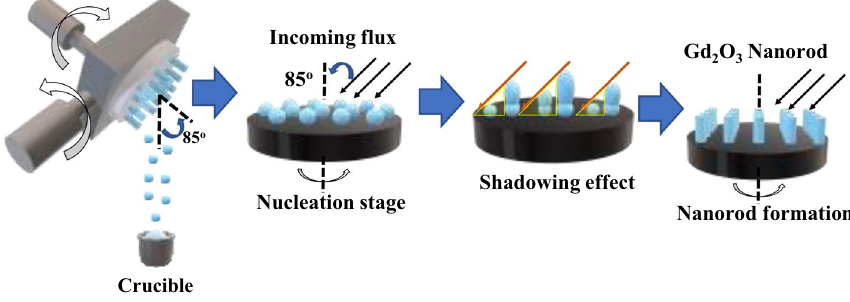
Fig. 2 XRD patterns of as- grown and annealed Gd